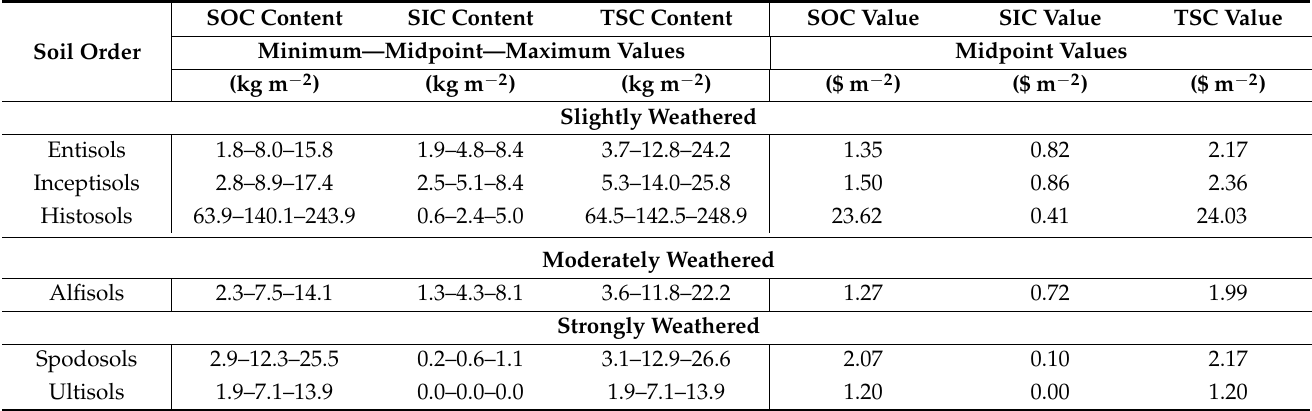
Table 4. Area-normalized content (kg m − 2 ) and monetary values ($ m − 2 ) of soil organic carbon (SOC), soil inorganic carbon (SIC), and total soil carbon (TSC = SOC + SIC) by soil order using data developed by Guo et al. (2006) [20] for the upper 2-m of soil and an avoided social cost of carbon (SC-CO 2 ) of $46 per metric ton of CO 2 , applicable for 2025 (2007 U.S. dollars with an average discount rate of 3%